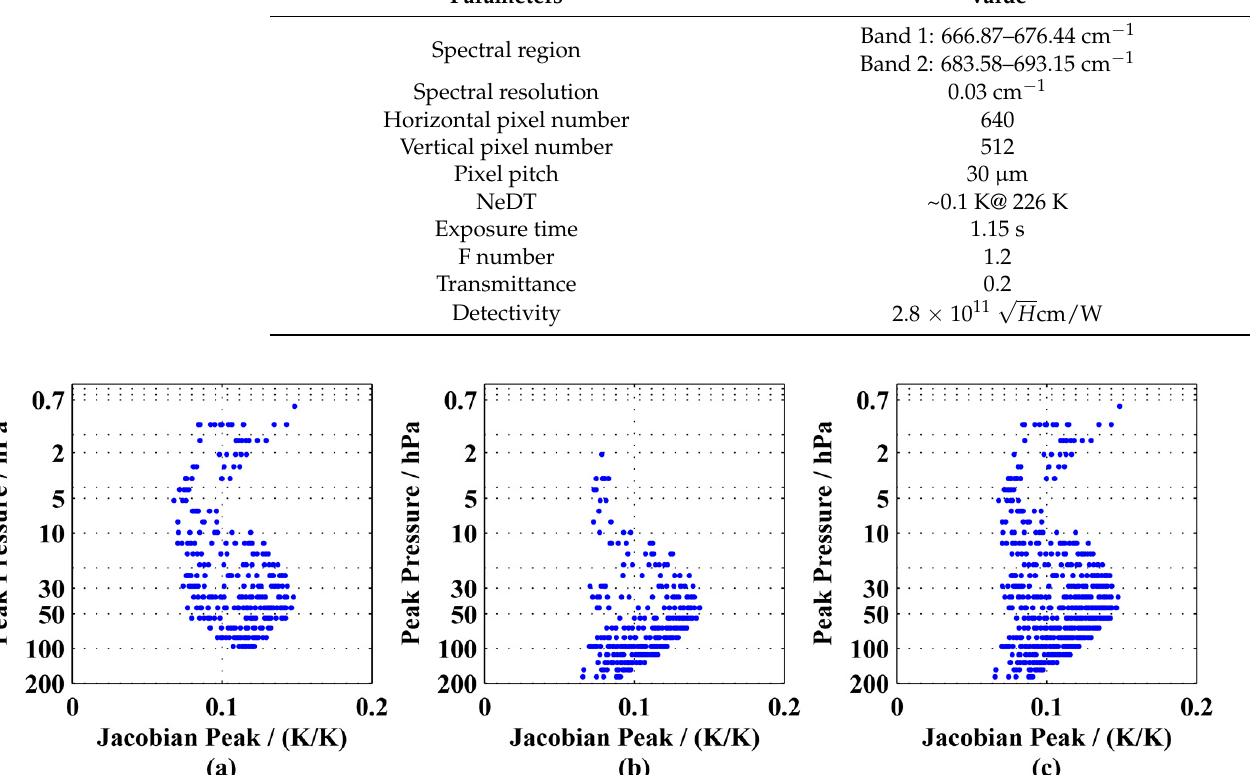
Table 4. System parameters of the spatial heterodyne spectrometer.